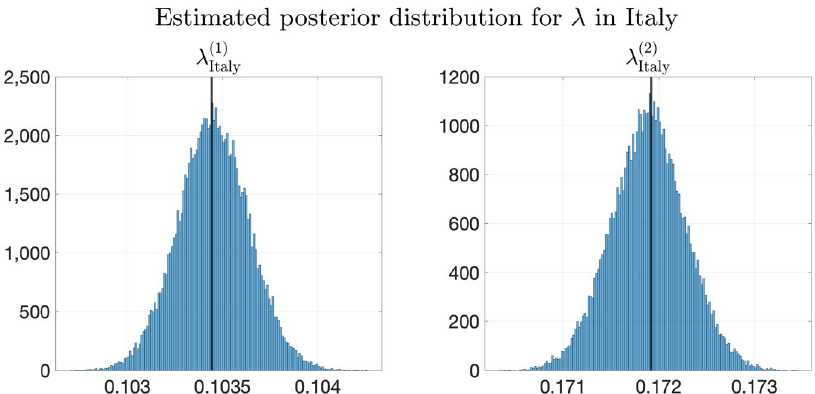
Figure 16. Estimated posterior distributions of (cid:31) in Italy. The vertical black lines represent the values of corresponding θ ∗ using Model